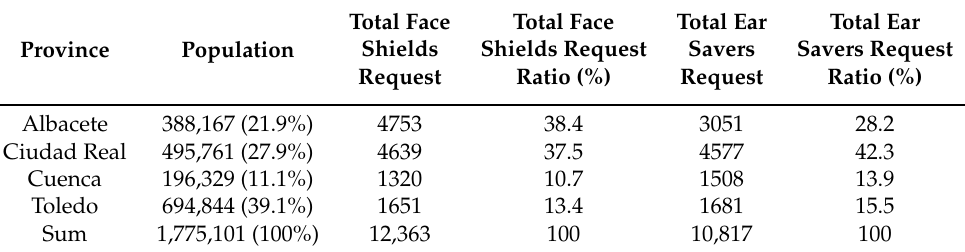
Table 7. Province population and PPE total delivered of each production province.